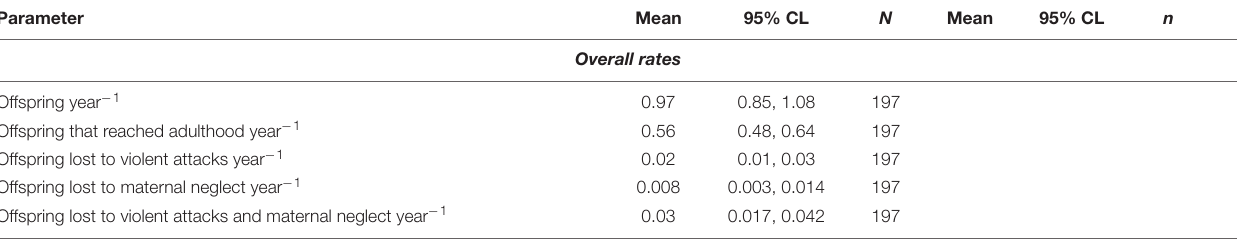
TABLE 2 | Annual rates of offspring produced or lost by breeding males.